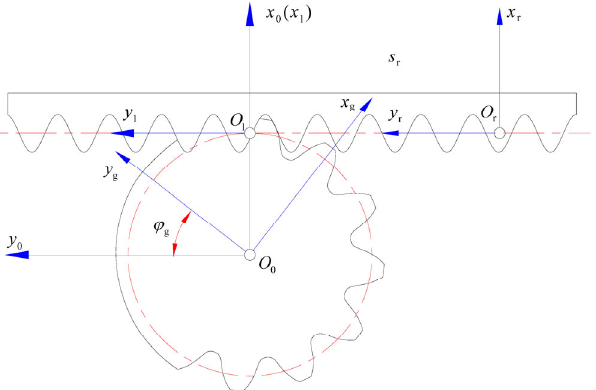
Fig. 2 Kinematics for the generation of helix gear by rack